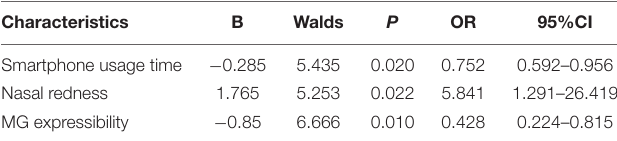
TABLE 3 | Multivariate logistic analysis of the increase in the severity of dry eyes. Characteristics B Walds P OR 95%CI Smartphone usage